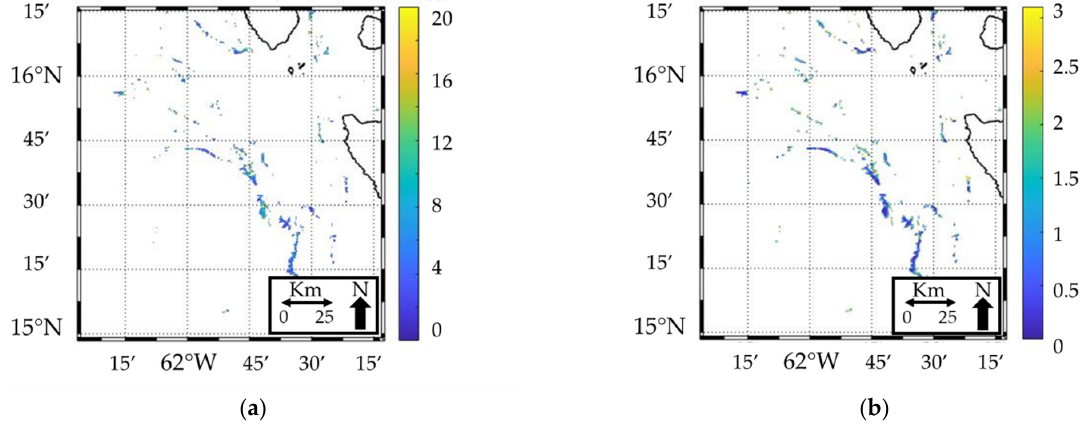
Figure 11. Spatial distribution of ( a ) FC (%) and ( b ) z retrieved by the neural network approach applied to the OLCI data acquired on 8 July 2017, over the study area (white square in Figure 2). Note that the data for which FC is lower than 0.1% and/or the depth is higher than 4.9 m were filtered out.